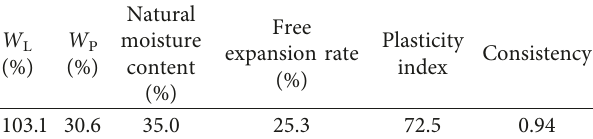
Table 1: Physical and mechanical properties of red